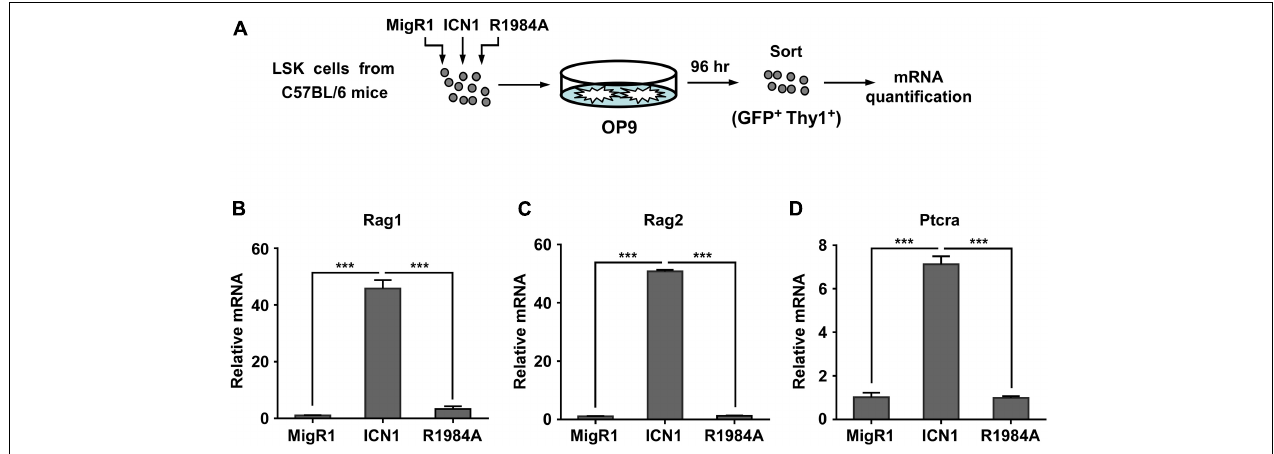
FIGURE 5 | Dimeric Notch1 activates Rag1 and Rag2 during thymocyte development. (A) Schematic presentation of the experimental procedure. LSK cells derived from C57BL/6 mice were transduced with retroviruses expressing the MigR1 vector, ICN1, or R1984A with GFP as a marker. After transduction, the infected cells were co-cultured with murine OP9 stromal cells for 96 h. GFP + Thy1 + T-lineage cells were sorted for mRNA quantification. (B–D) qRT-PCR analysis showing the mRNA expression of Rag1 (B) , Rag2 (C) , and Ptcra (D) in sorted cells. *** p <